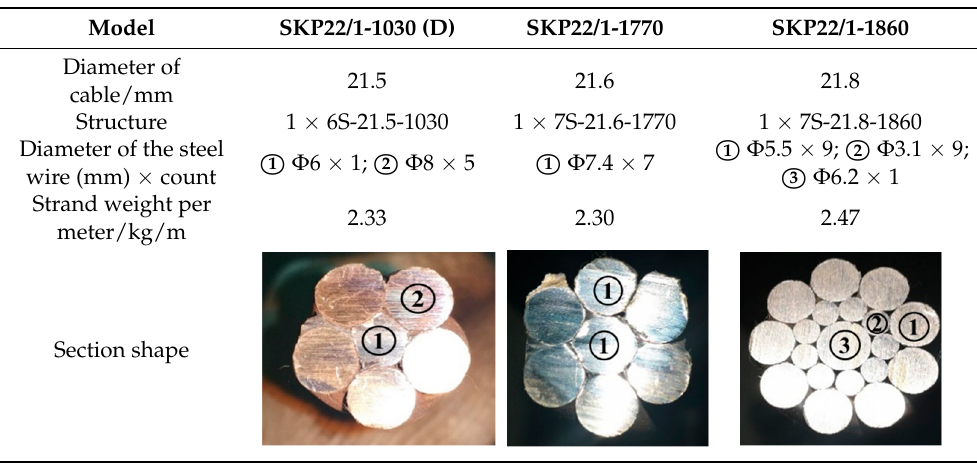
Figure 1. Dynamic load impact mechanical model of roadway support system. Table 1. The cable type and structure characteristics.